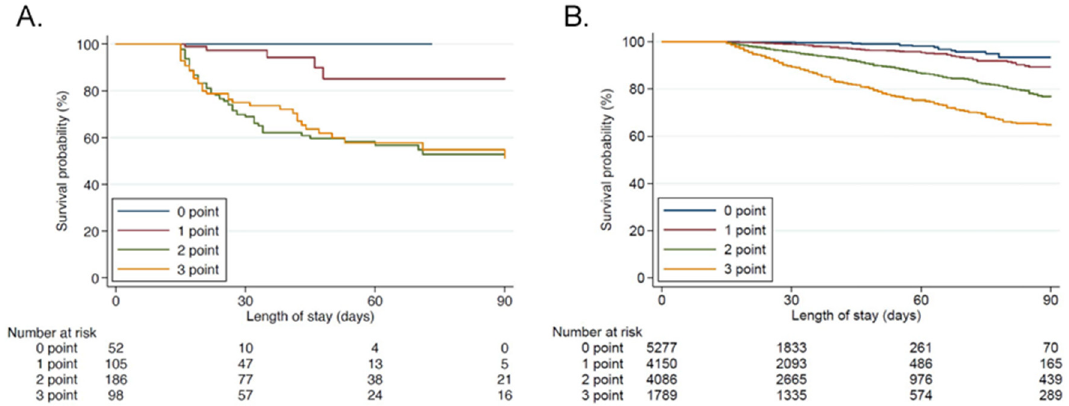
Figure 4. Kaplan Meier curve with each criterion point. The significance of differences is evaluated with the Log-rank test. ( A ): derivation cohort, ( B ): validation cohort. Table 3. Patient characteristics according to PICS criteria developed in the validation cohort.